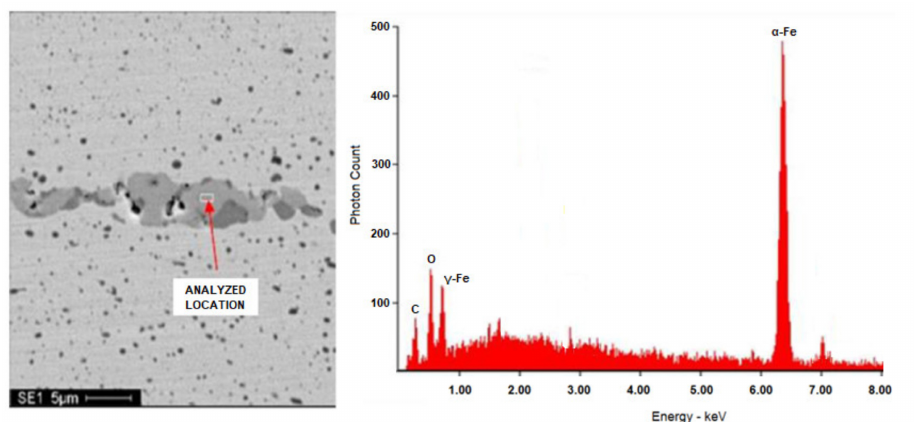
Figure 3. EDS analysis. Source: own research.